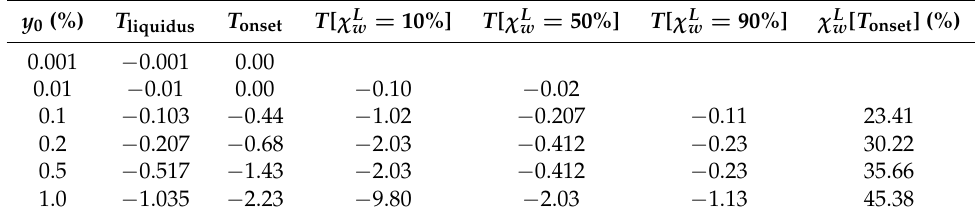
Table 1. Temperatures (in ◦ C) and mass fractions (in %) characterizing the melting temperature ranges for very dilute